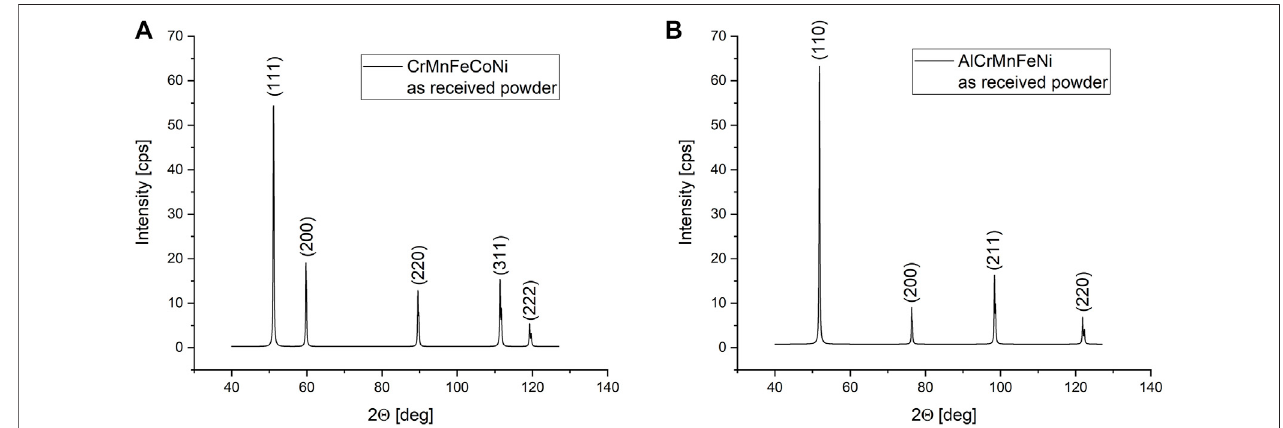
FIGURE 3 | XRD patterns obtained on the (A) CrMnFeCoNi and (B) AlCrMnFeNi alloy, showing a single-phase FCC (A) and a single-phase BCC (B) .